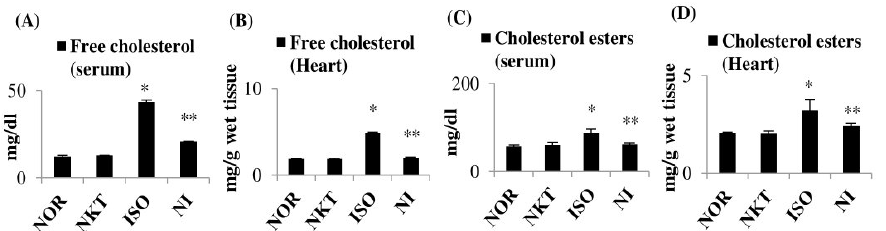
Figure 7. Effect of NKT on free cholesterol and cholesterol esters in the serum and heart: ( A – D ) the levels/concentrations of free cholesterol and cholesterol esters in the serum and heart. Each column is the mean ± SEM for eight rats in each group; * p < 0.05 as compared to the normal control (Group-I), ** p < 0.05 as compared to the ISO control (Group-III) (DMRT).